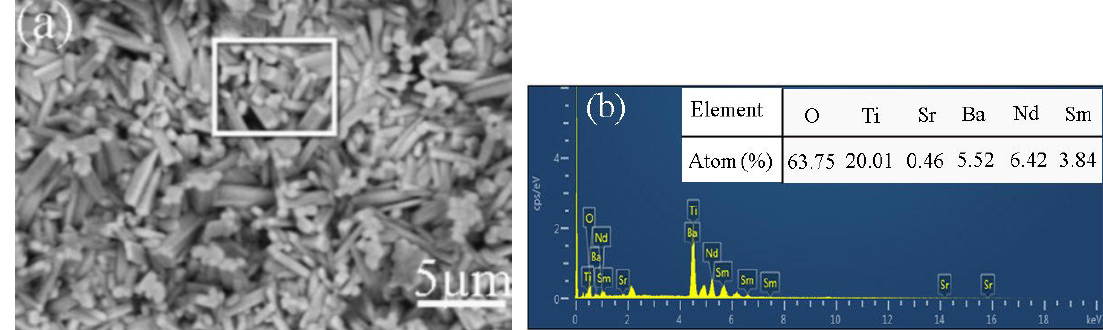
Fig. 3 EDX analysis of the (Ba 1 − x Sr x ) 4 (Sm 0.4 Nd 0.6 ) 28/3 Ti 18 O 54 ceramic ( x = 0.08) sintered at 1440 ℃ for 4